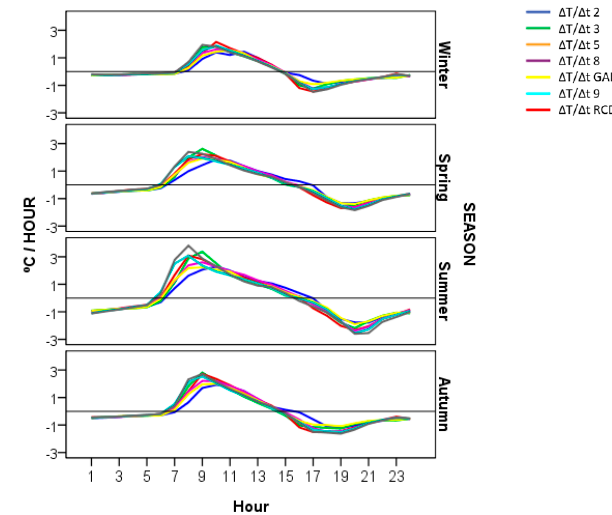
Figure 6. Average hourly heating and cooling rate for each LCZ.